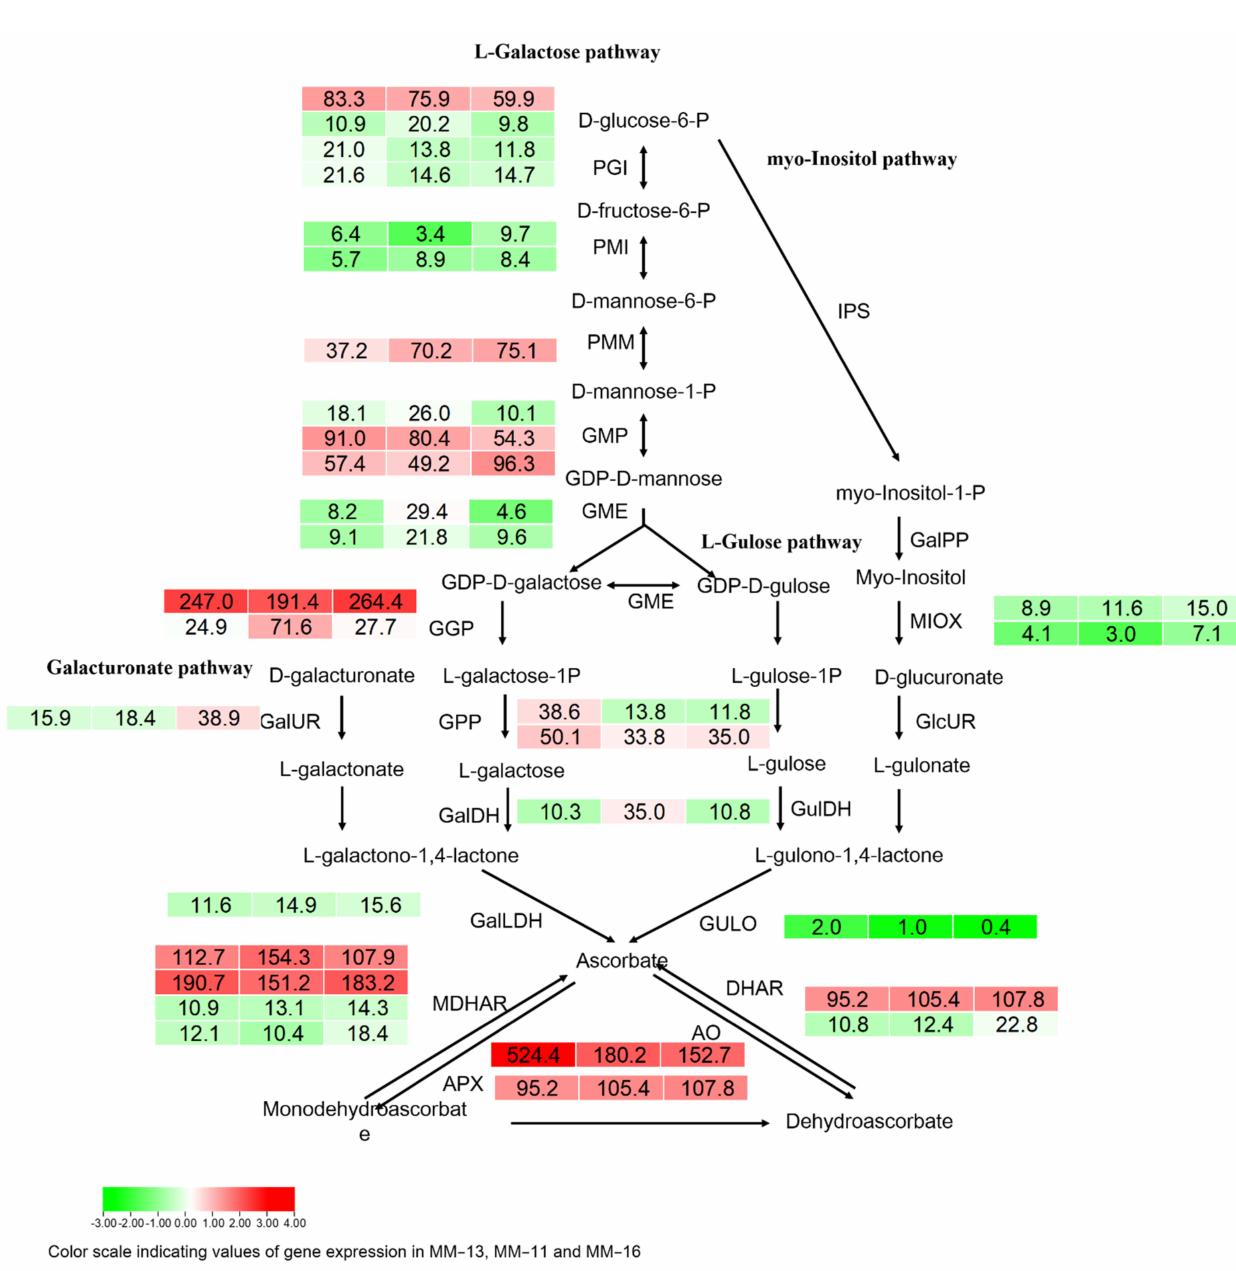
Figure 8. Ascorbic acid biosynthesis pathways and recycling pathways in kiwifruit. The heatmap of DEGs was analyzed, with FPKM values of genes in